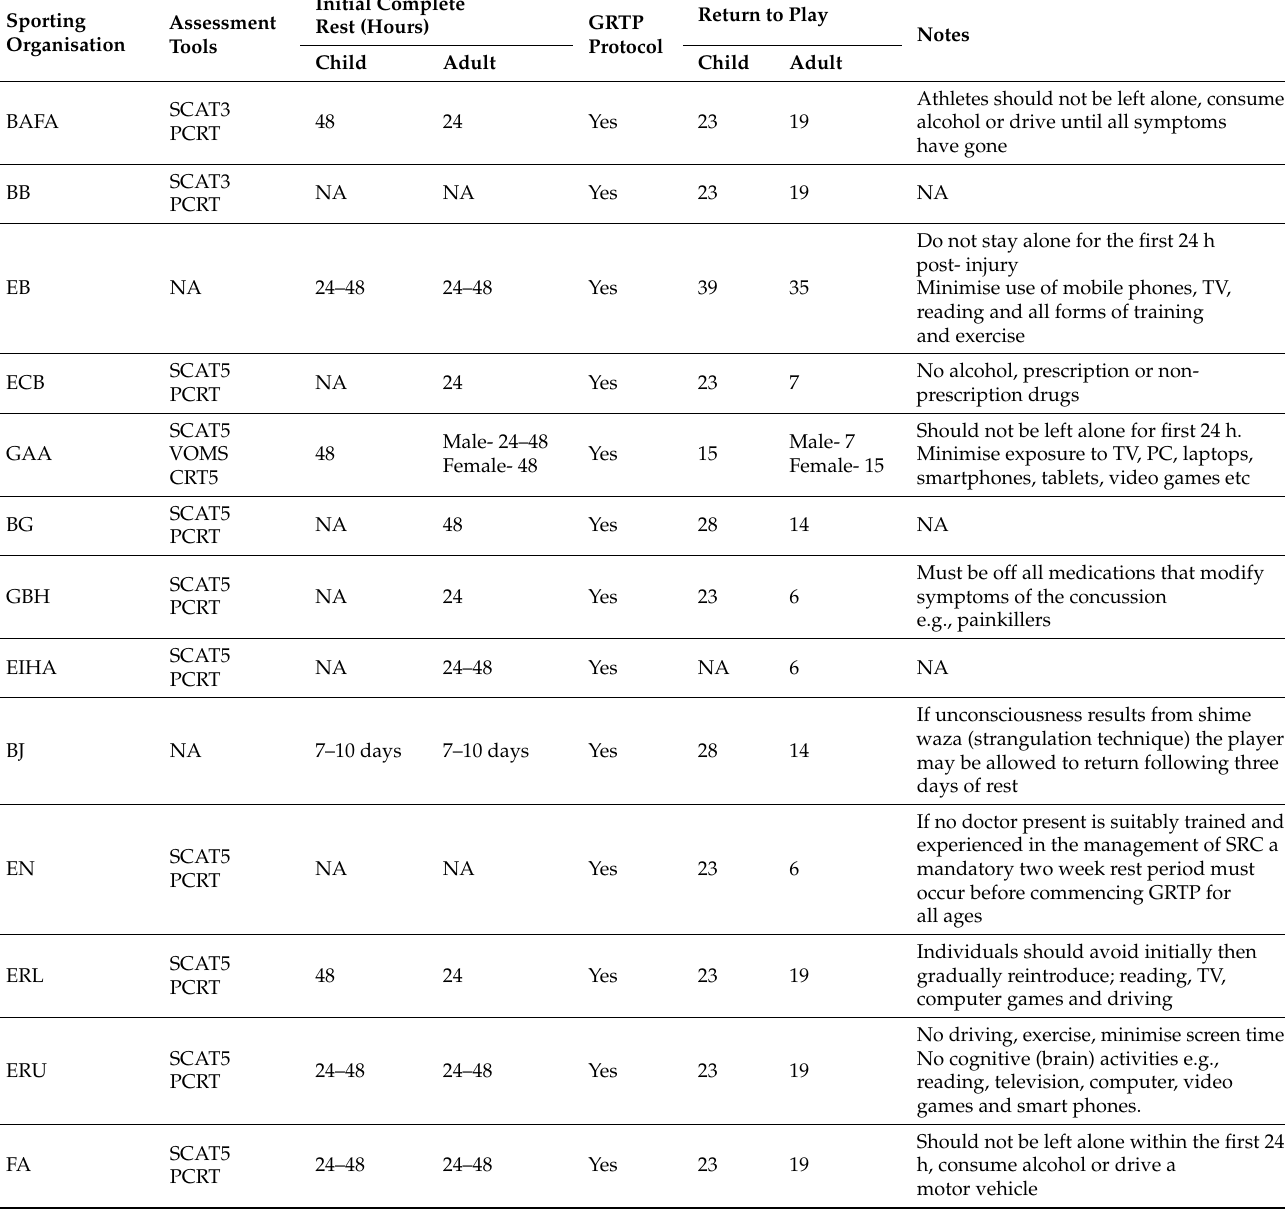
Table 2. Summary of SRC guidelines published by UK sporting